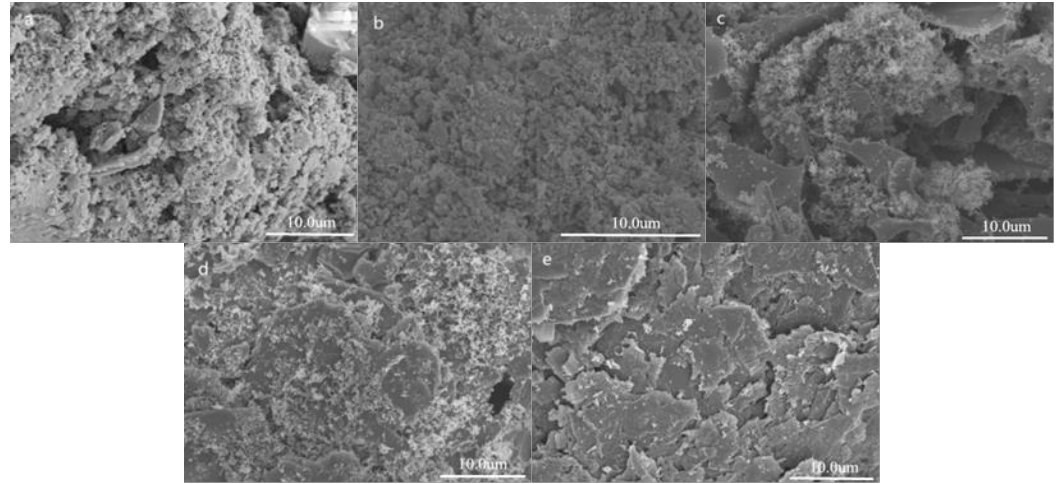
Figure 7. FESEM images of the carbon residues of ABS ( a ), ABS 1 ( b ), ABS 2 ( c ), ABS 3 ( d ), and ABS 4 ( e ).